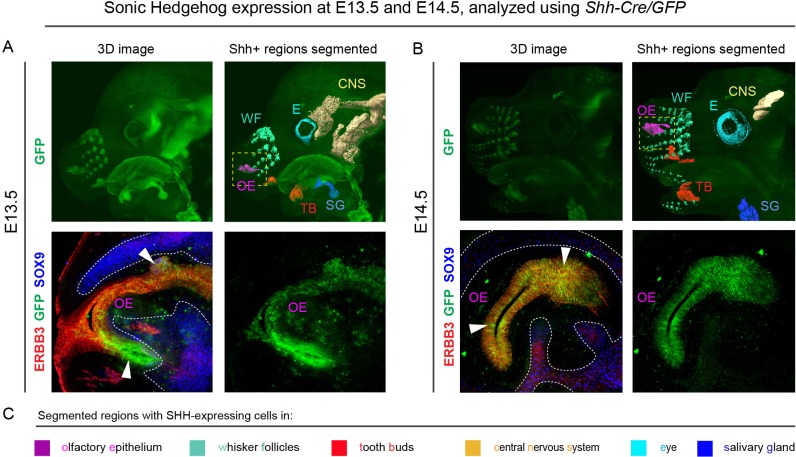
Shh is expressed through the later facial development in distinct regions of the head.The expression pattern of Shh between developmental stages E13.5 (A) and E14.5 (B), segmented Shh-expression regions are color-coded and clarified in a legend (C). Immunohistochemical staining (25 µm cryosections) shows olfactory neuroepithelium as ERBB3 positive and surrounding cartilage as SOX9 positive. White arrows point at GFP-expressing parts of olfactory neuroepithelium. Yellow dotted linein the upper panels shows the area selected for immunohistological staining shown in the bottom panels. White dotted line outlines the shape of cartilage. Upper panels were imaged using a Light Sheet Microscope system Z1 from Carl Zeiss. Lower panels were obtained with confocal microscope.